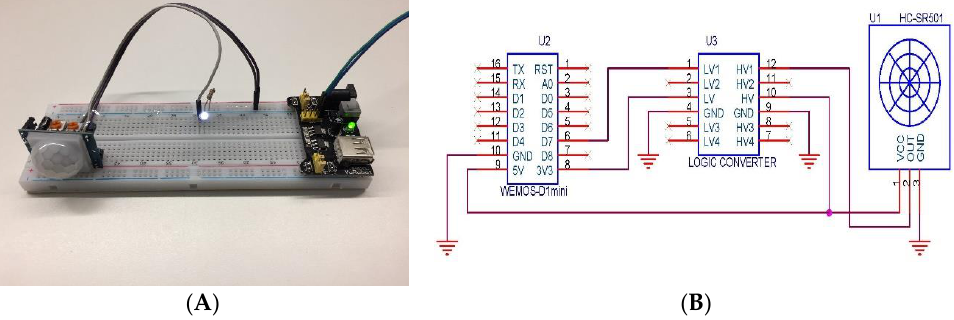
Figure 2. Presence detection system circuit. ( A ) shows the prototype and ( B ) shows the connections.